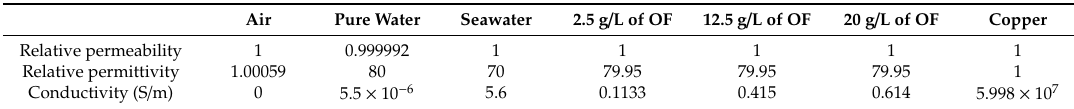
Table 2. Values used in the